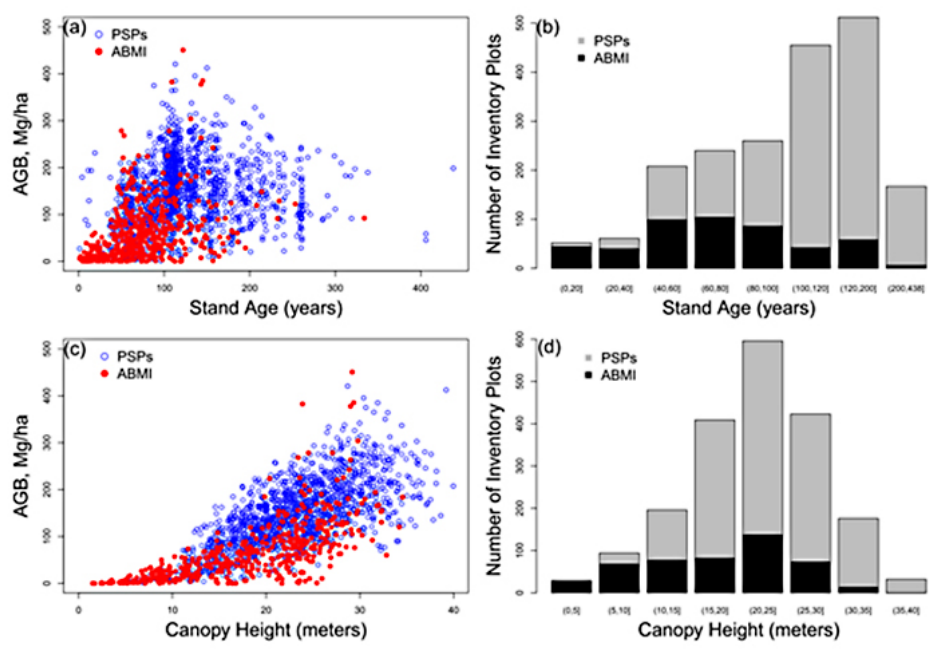
Figure 2. Total tree aboveground biomass (AGB) versus canopy height and stand age of 1968 inventory plots. Table 1. Pearson correlations of log-transformed tree aboveground biomass (AGB) with climatic variables, elevation, and observed canopy height, after accounting for spatial